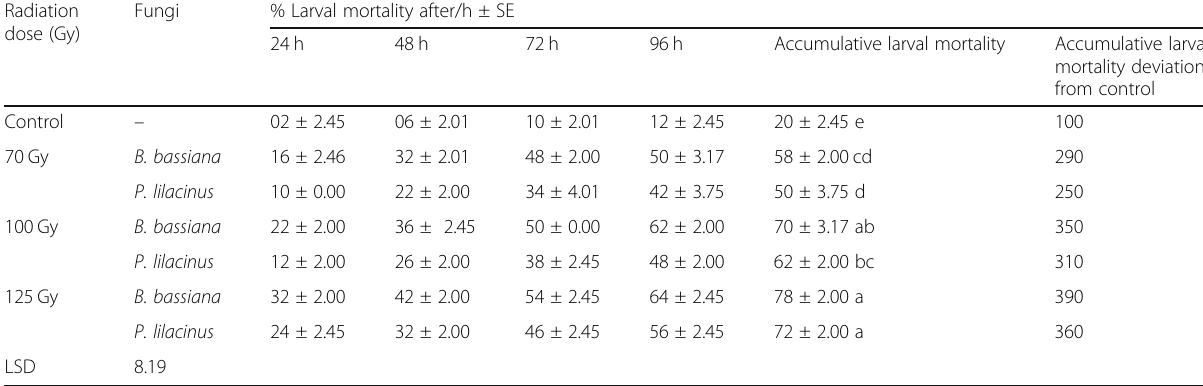
Table 3 Effect of gamma irradiation combined with the LC 50 of the entomopathogenic fungi on the percentage larval mortality of Galleria mellonella descending from the irradiated parental males Radiation dose (Gy)